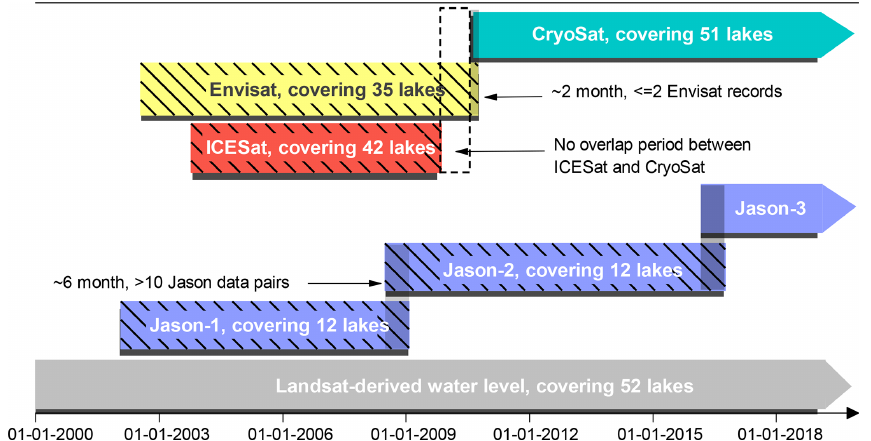
Figure 1. Spatial (the number of lakes covered) and temporal coverage and their overlap periods of multiple satellite altimetric missions used in this study, including Jason-1/2/3, Envisat, ICESat, and